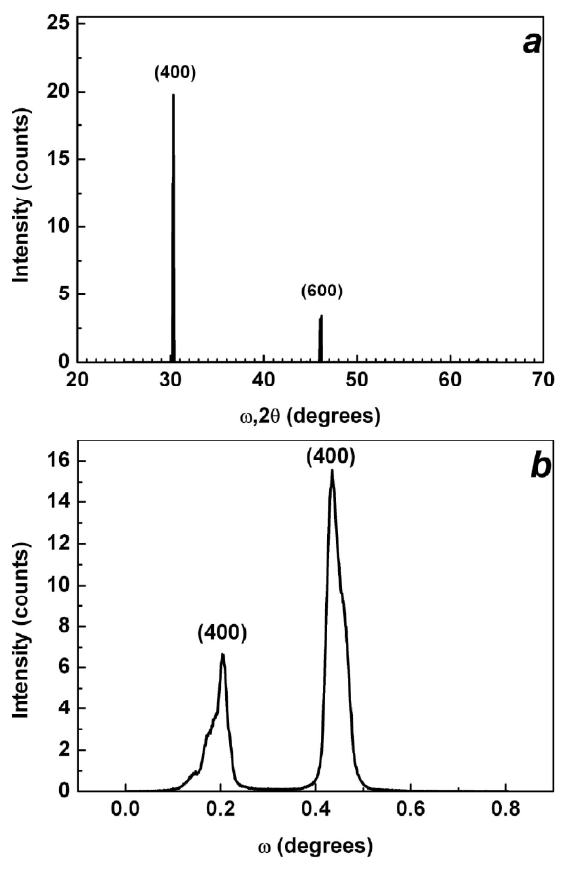
Fig. 1. XRD patterns of  -Ga mode (a) and in (  ) mode (b).